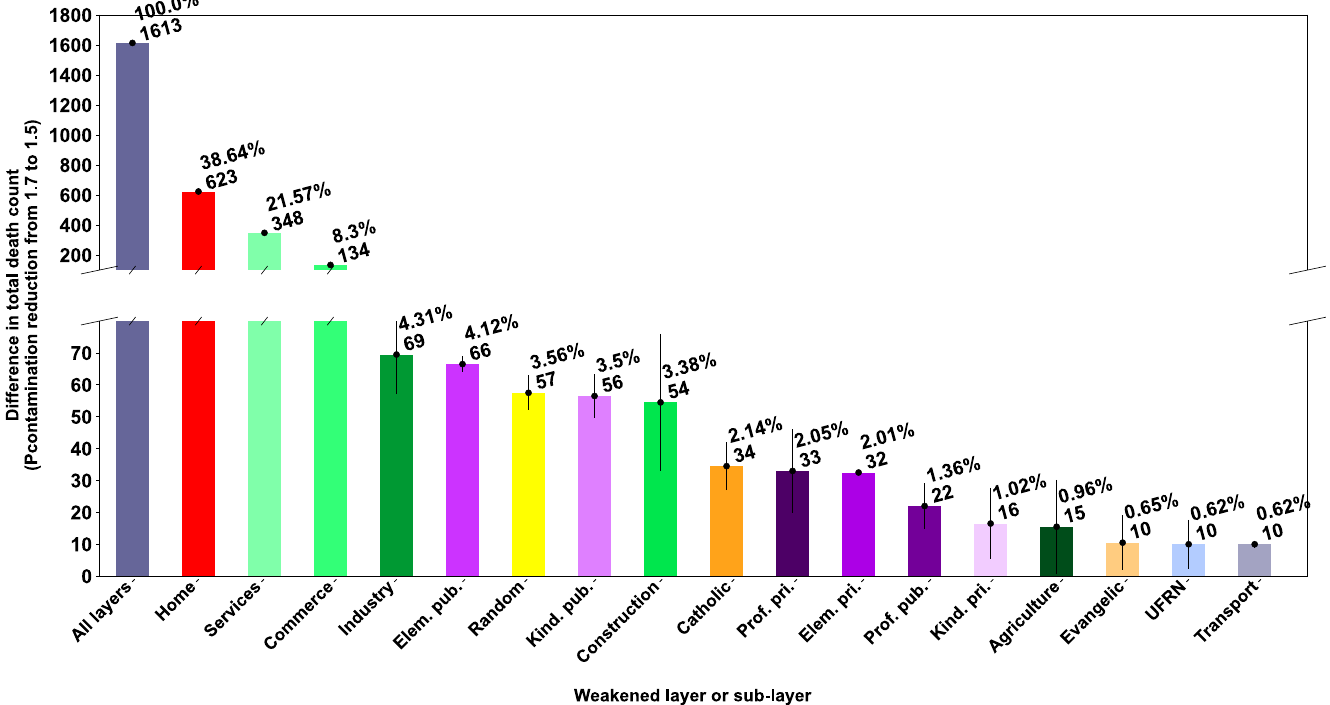
Fig 4. Sensitivity analysis indicates an inhomogeneous impact of different transmission networks in the outbreak progression. The difference in the total number of deaths with a reduction of P contamination from 1.7 to 1.5 in all layers, in each layer or sub-layer. Graphics represent median (bar), quartiles (line), absolute median difference to high-value simulation and relative difference to a reduction of P value in all contamination